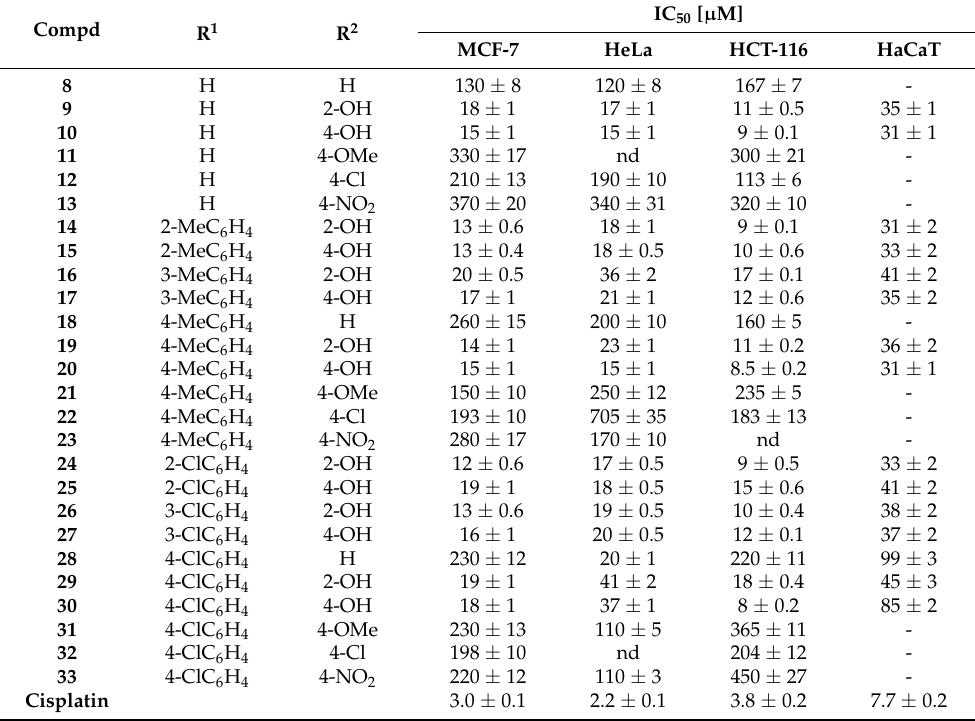
Table 1. IC 50 values for compounds 8 – 33 determinated after 72